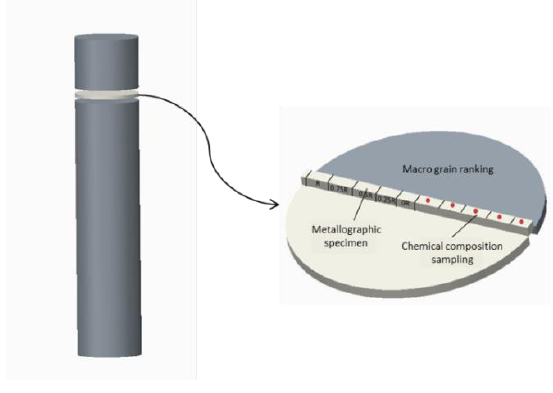
Figure 3. Schematic diagram.